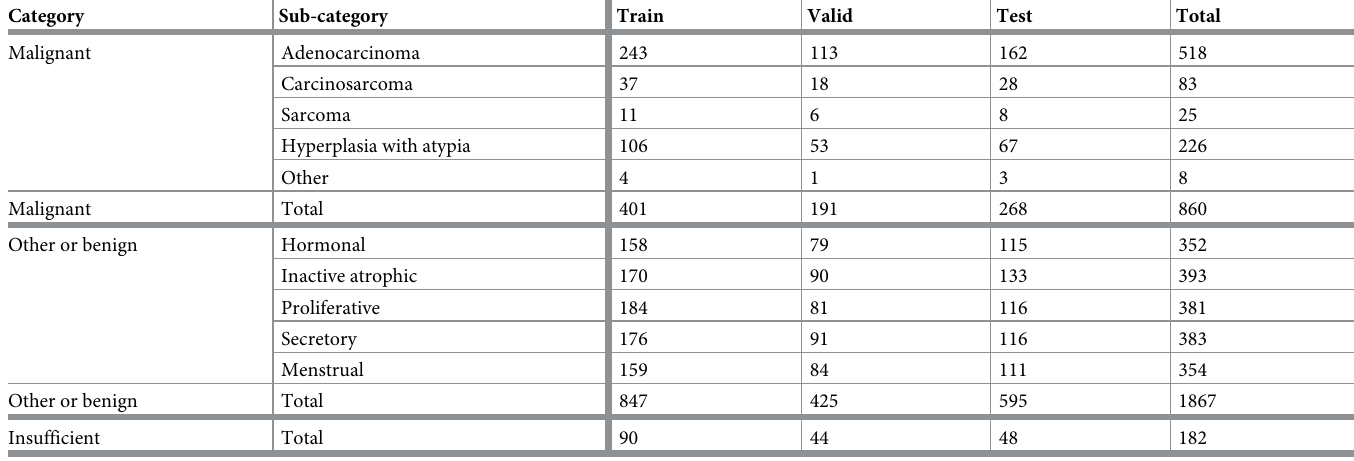
Table 1. Number of slides per set, category and